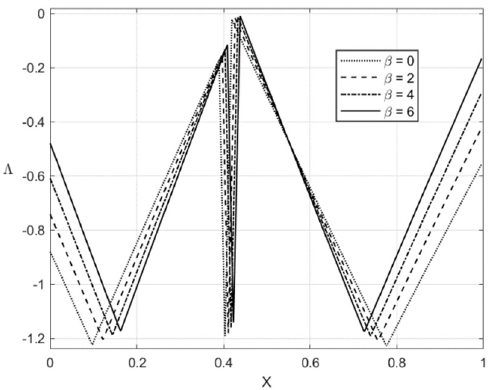
Figure 13. Geometric illustration that the condition (64) is satisfied if f = 0 and 0 ≤ β ≤ 6.